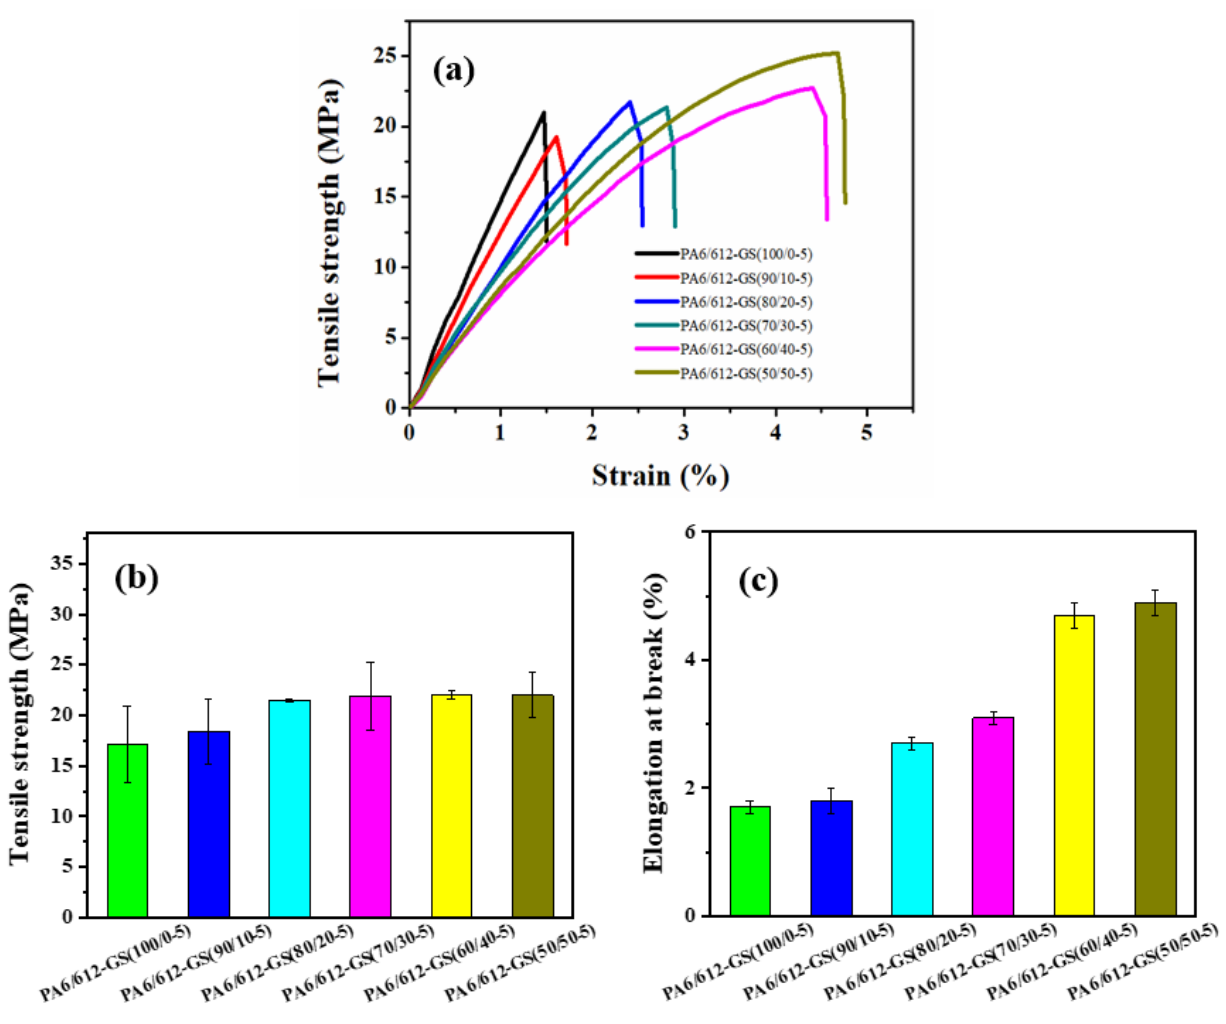
Figure 8. Mechanical properties of PA6/612-GS composites: ( a ) stress–strain curves, ( b ) tensile strength, and ( c ) elongation at break.